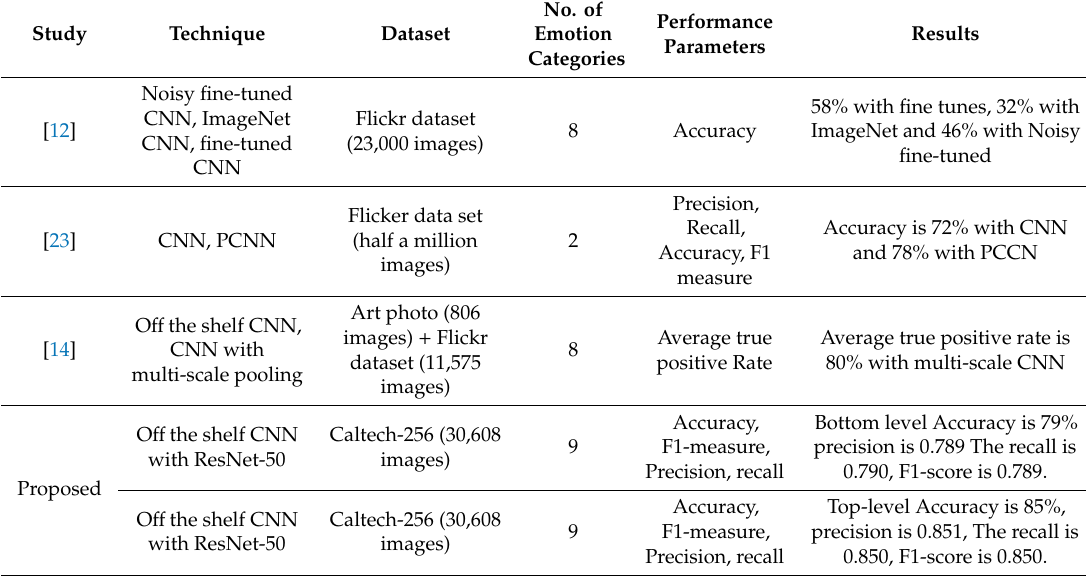
Table 3. Comparison of the proposed method with some well-known deep learning-based inferring emotion tag